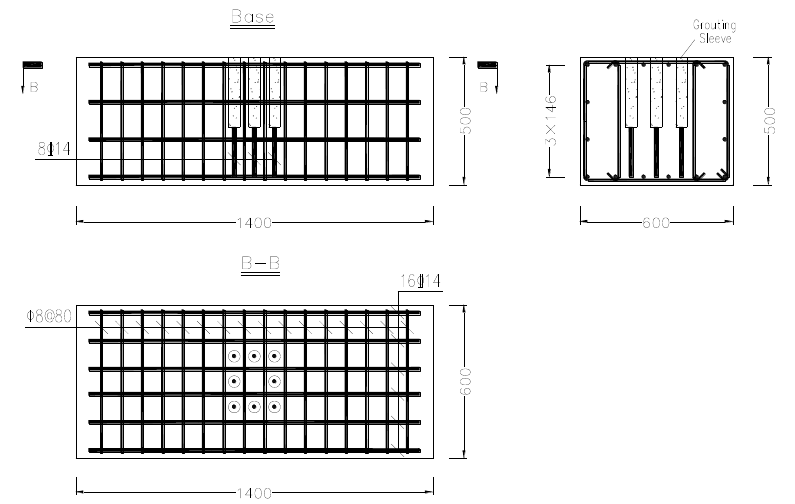
Figure 7. The dimensions and reinforcement details of the base (unit: mm). Table 4. Parameters of the longitudinal reinforcement and